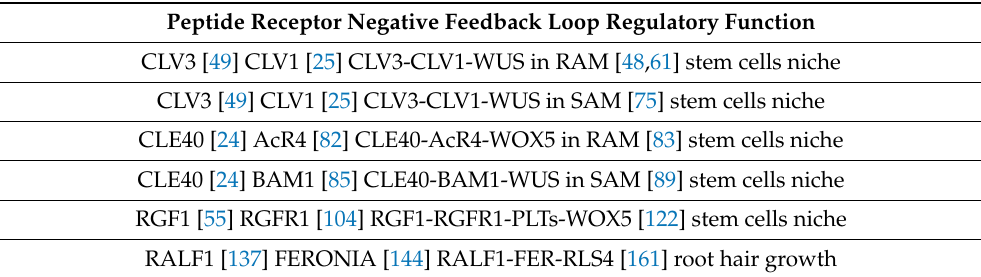
Table 1. Molecular mechanisms of regulation of root development by